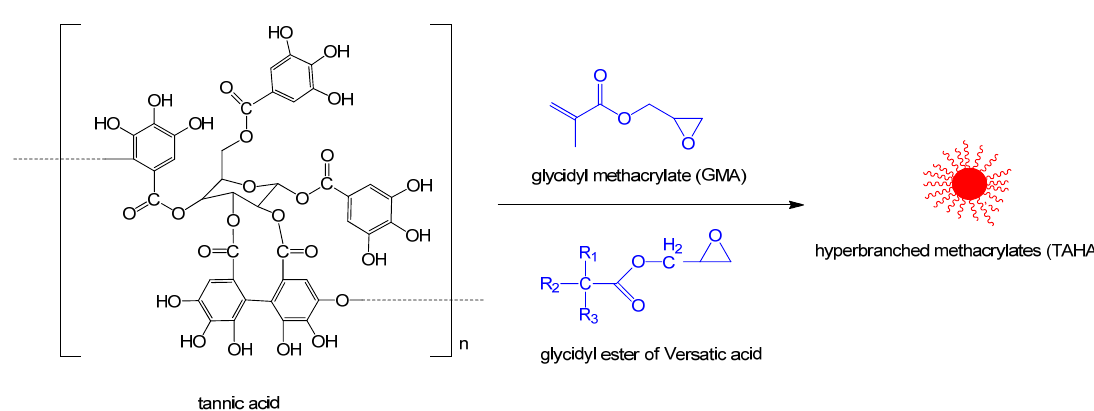
Figure 8. Synthesis of TAHAs from tannic acid via grafting with GMA and CE10 [58].